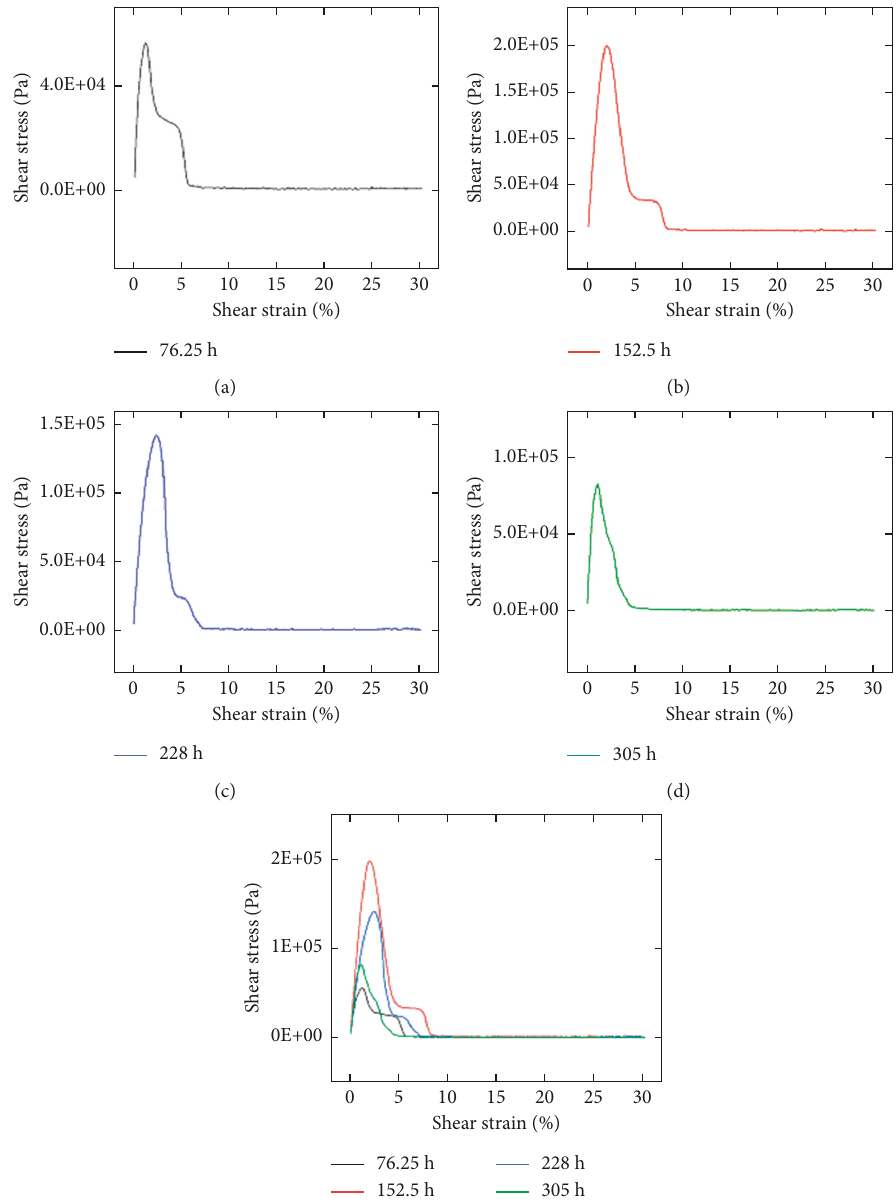
Figure 12: LAS results of T622 modified asphalt subjected to different UV aging